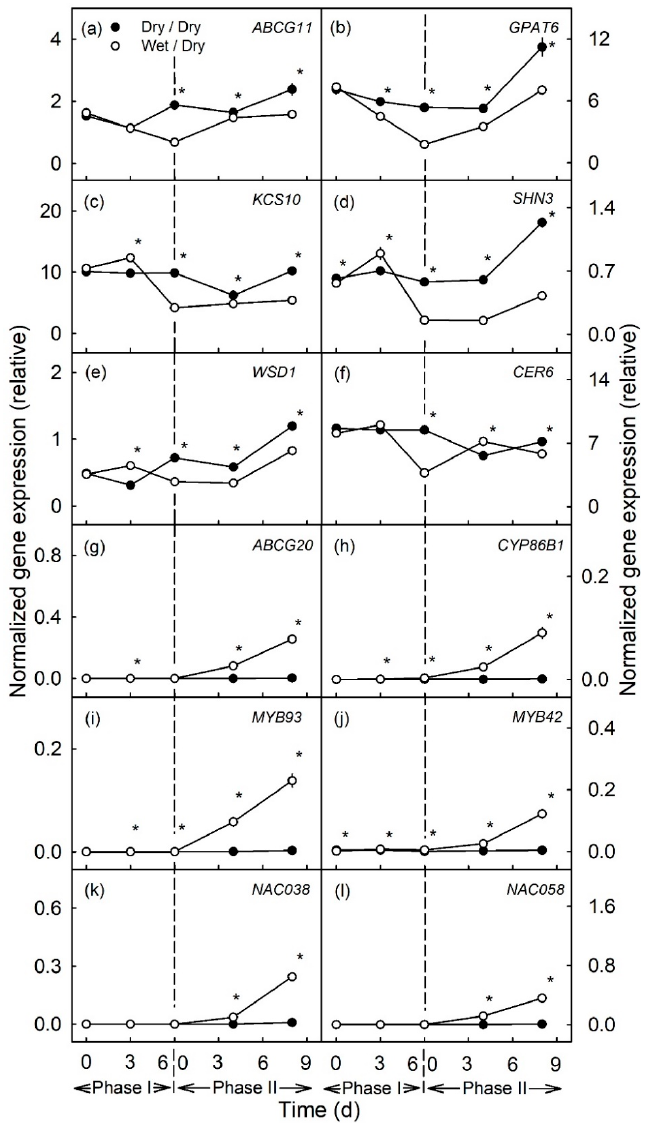
Figure 1. Time courses of expression of genes related to cutin and wax synthesis ( a – f ) and to suberin and lignin synthesis ( g – l ) of apple fruit skin during (Phase I) of exposure to moisture and after exposure was discontinued (Phase II). During Phase I, a patch of the fruit skin was exposed to moisture for 6 d beginning at 31 days after full bloom (DAFB) (wet). During the subsequent Phase II, moisture was removed, and the patch was exposed to the atmosphere (dry). Moisture-exposed patches of the fruit skin are referred to as wet/dry, unexposed control patches as dry/dry. The end of moisture exposure is indicated by the vertical dashed line. The expression values are means ± SE of three independent biological replicates comprising ten fruit each. The ‘*’ indicates significant differences between dry/dry and wet/dry at p ≤ 0.05 (Student’s t -test). In contrast, there was no change in expression of genes related to suberin synthesis ( ABCG20 , CYP86B1 , MYB93 ) during moisture exposure (Phase I) (Figures 1g–i and 2g–i). MYB42 , a regulator of lignin synthesis, was slightly but significantly up-regulated during moisture exposure (Figures 1j and 2j). Meanwhile, NAC038 and NAC058 , that do not yet have assigned functions, were not differentially expressed during Phase I (Figures 1k–l and 2k–l). After discontinuation of moisture exposure (Phase II), the expression of cutin- and wax-related genes in the moisture-exposed patches increased again slightly but the relative expressions were still significantly lower than the expressions of these genes in the